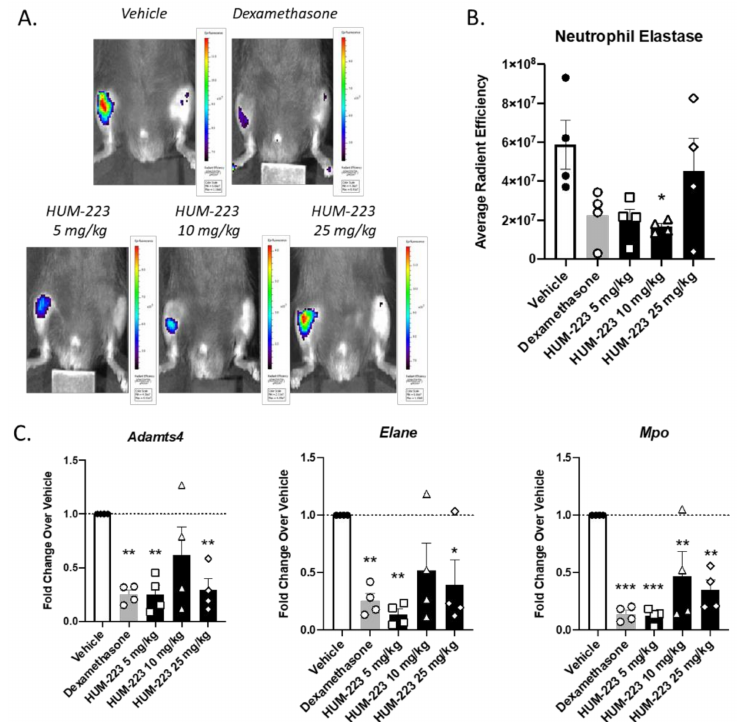
Figure 4. Anti-inflammatory effect of HUM-223 in zymosan-induced arthritis. Mice were treated with vehicle (white bars), dexamethasone (2 m/kg, grey bars) or HUM-223 (black bars). ( A )